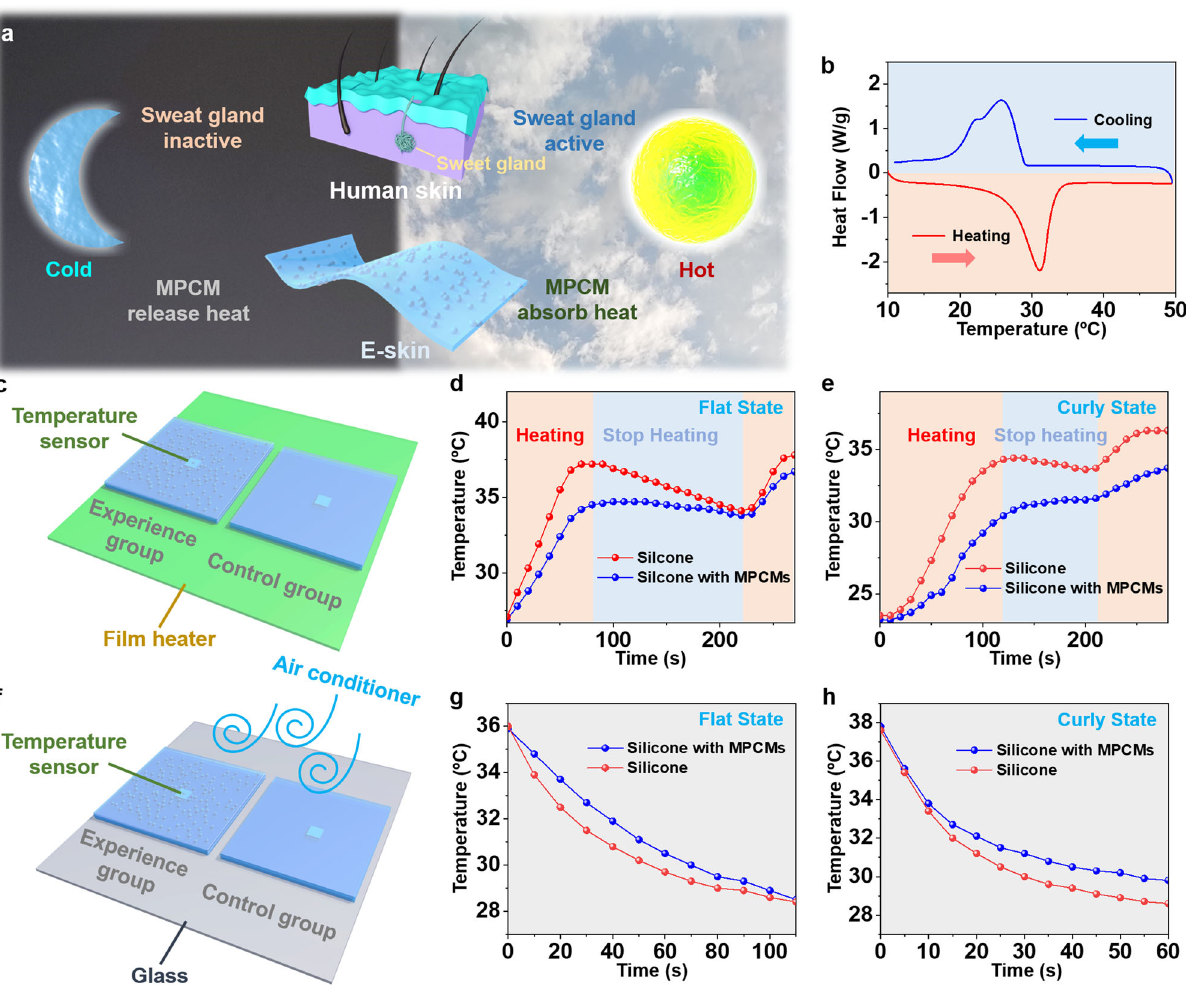
Fig. 2 Dynamic thermoregulating ability of ME-skin. a Schematic diagram of ME-skin inspired by human skin sweat gland structure. b The DSC curve of ME-skin. c Two layers of 5 × 5 cm ME-skin and two layers of silicone elastomer without M-paraf fi n were placed on a fi lm heater, and the temperature sensors were placed in the middle of the two fi lms. d The measured temperature change with time when ME-skin and silicone elastomer were laid fl at. The temperature of the fi lm heater was set to 35 °C. e When the heating temperature of the fi lm heater was 35 °C, the temperature changes of curly ME-skin and silicone elastomer. f The experimental group and the control group were placed on the glass to study the temperature changes under the environment of air conditioning operation. g When the air conditioning temperature was 16 °C, ME-skin and silicone elastomer without M-paraf fi n temperature versus time curve at an initial temperature of 36 °C. h The time- temperature curve of curly ME-skin and silicone elastomer. The air conditioning temperature was set to 16